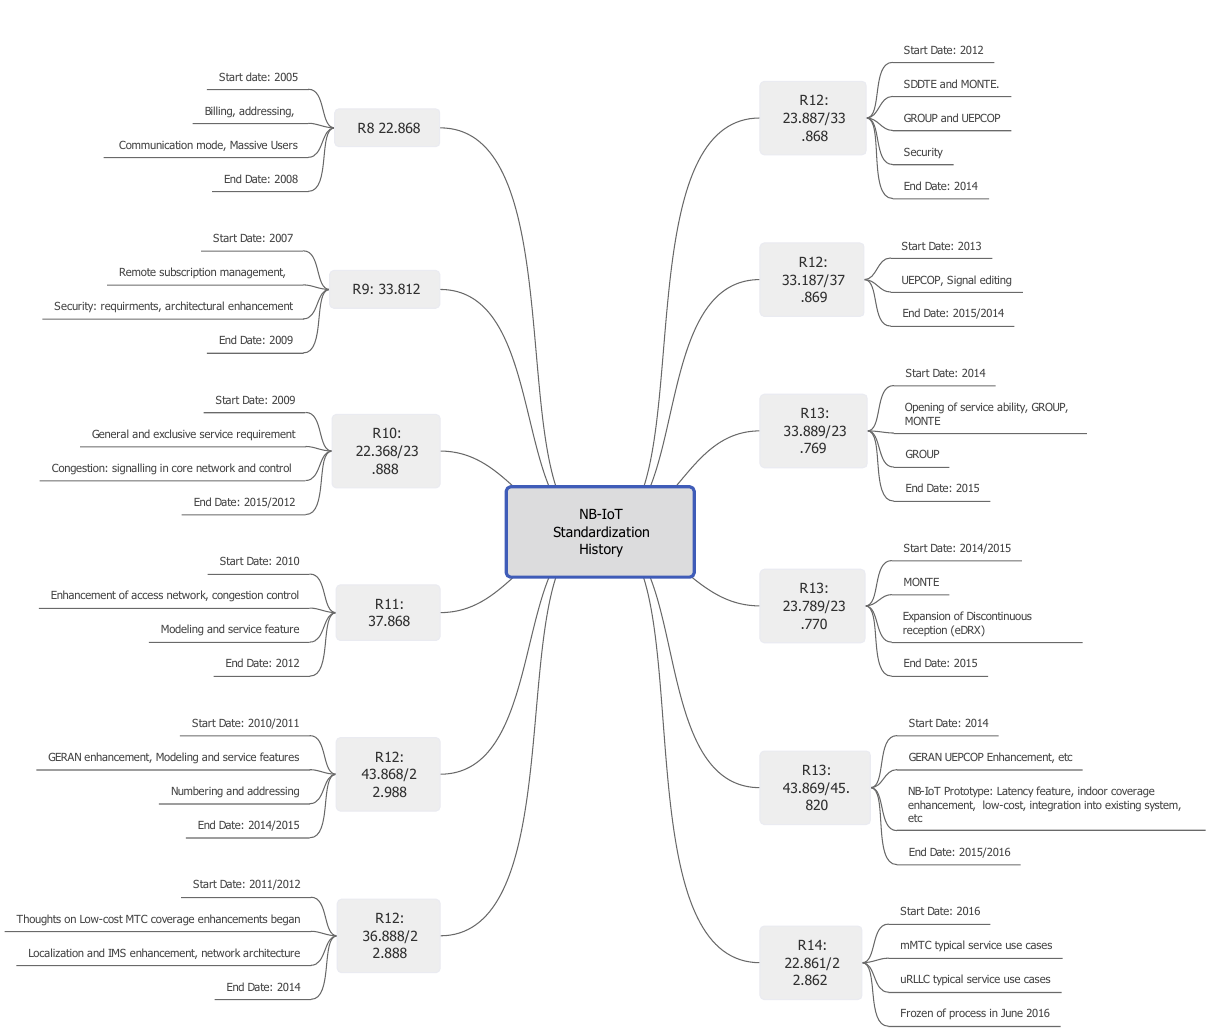
Figure 8. A unique representation of the NB-IoT standardization